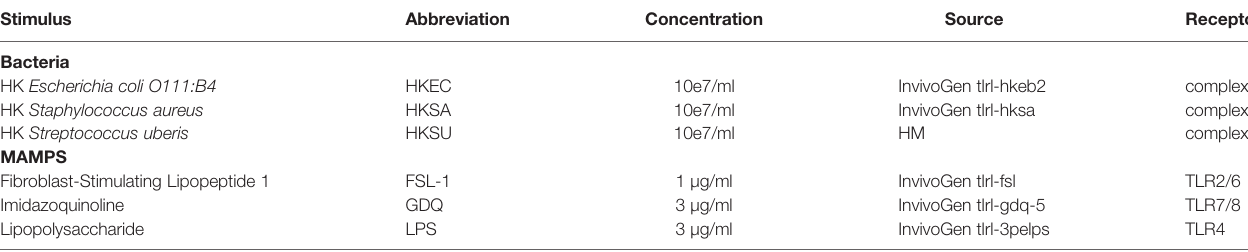
HK, heat-killed; HM,